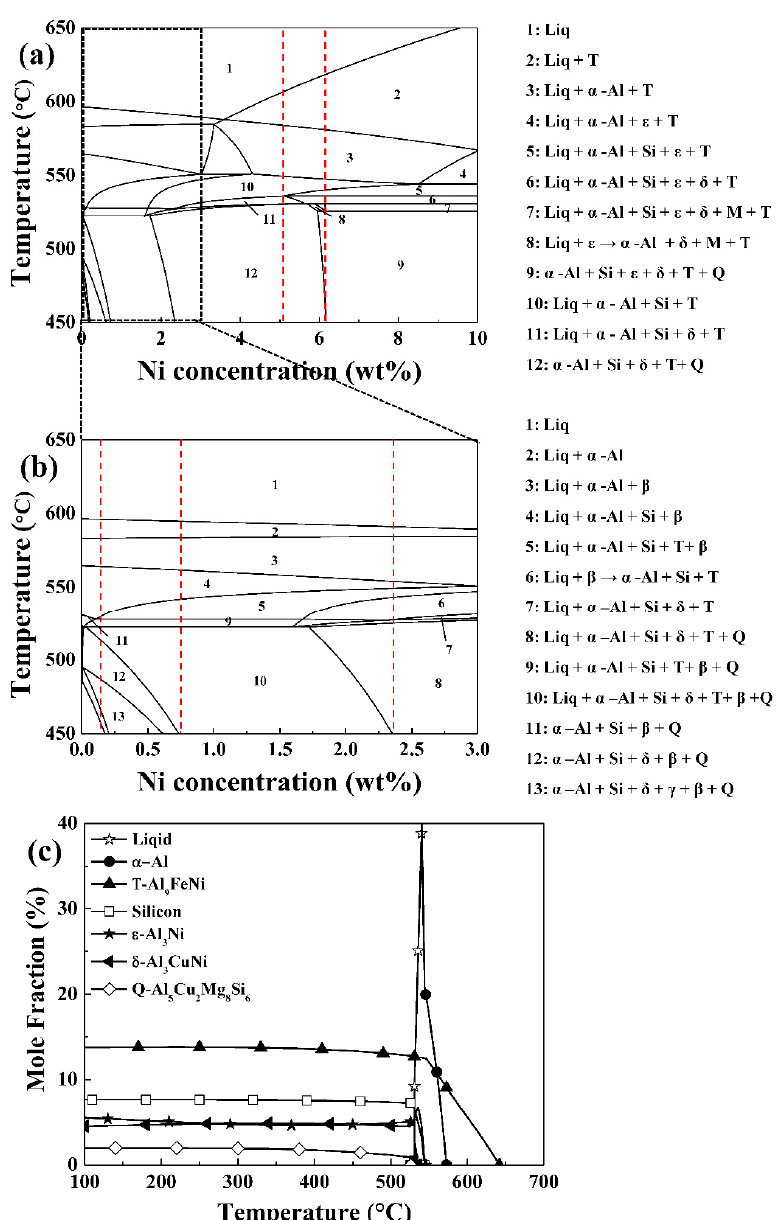
Figure 6. ( a , b ) Calculated phase diagram of the Al–Si–Cu–Mg–Fe system for different nickel ranges (0–10%), and ( c ) mole fraction of different phases as a temperature function in the Al-7.98Si-2.8Cu- 0.64Mg-0.74Fe-8.62Ni